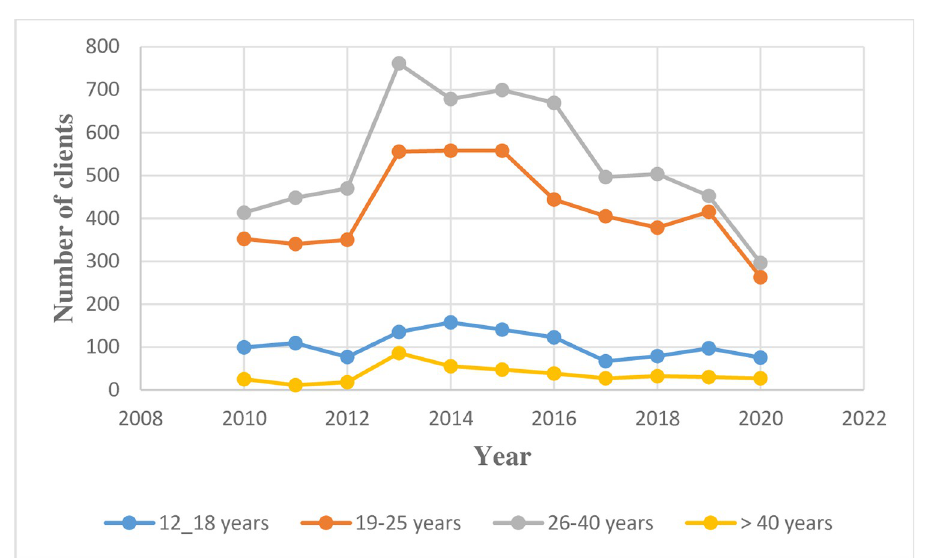
Fig 1. Trends in the annual number of clients for Abortion procedures stratified by